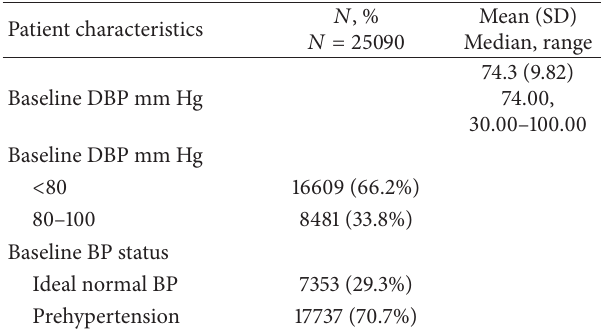
Table 2: Demographics and baseline